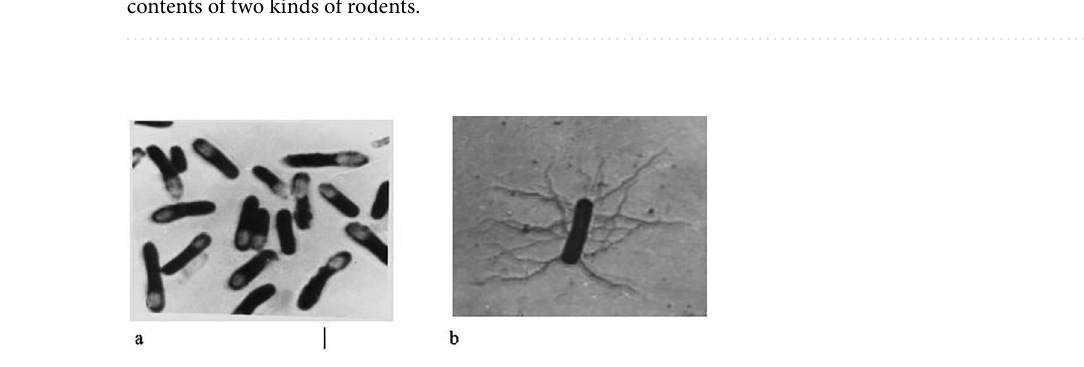
Figure 3. ( a ) Morphological characteristics, ( b ) electron micrograph of Clostridium botulinum.